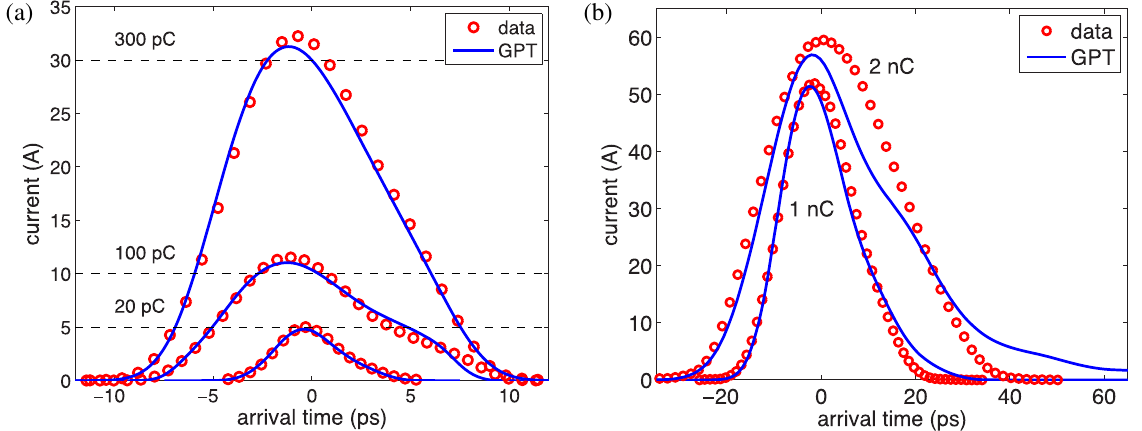
FIG. 9. The simulated and measured current profiles for each bunch charge.